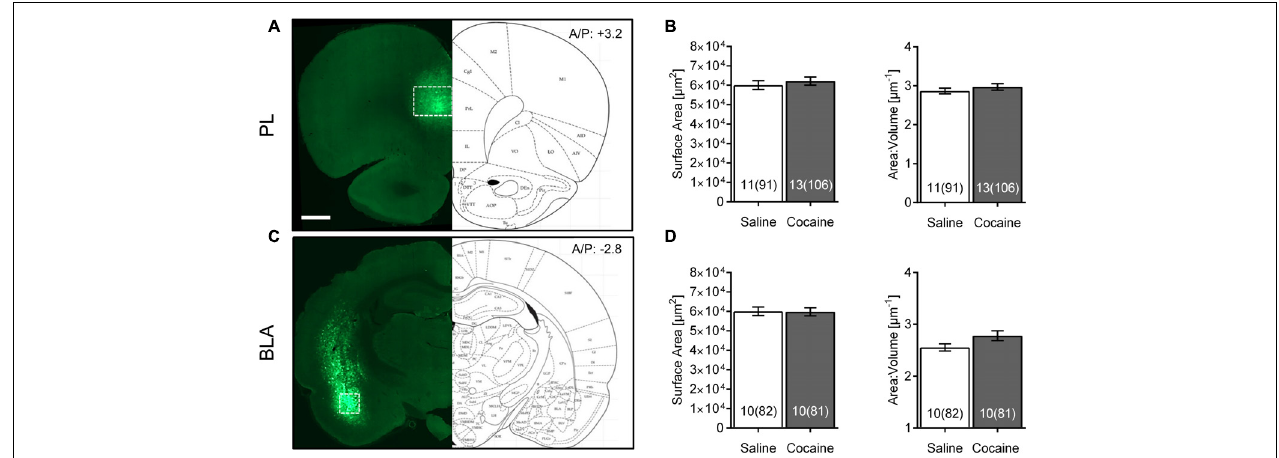
FIGURE 2 | Cocaine self-administration and extinction does not affect morphometric features of PL or BLA astrocytes. (A) Scan of a brain slice showing the intensity and range of expression of the AAV5 Lck-GFP. The white box shows the area of PL where imaging was performed. 10 × magnification, scale bar: 1 mm. (B) No significant difference was observed in astrocyte surface area and surface area:volume ratio in the PL following cocaine self-administration and extinction. Bar insert: number of animals and number of cells (in parentheses). (C) Lck-GFP expression in BLA. The white box shows the area where imaging was performed. (D) No significant difference was observed in astrocyte surface area and surface area:volume ratio in the BLA following cocaine self-administration and extinction. Bar insert: number of animals and number of cells (in parentheses).